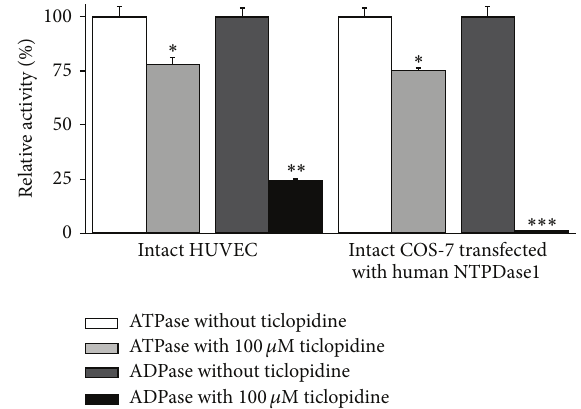
Figure 1: Influence of ticlopidine on intact HUVEC and COS-7 cells transfected with an expression vector encoding human NTPDase1. The substrate (ATP or ADP) was added together with ticlopidine, both at 100 𝜇 M. Relative activities are expressed as the mean ± SD of 3independentexperimentswithconfluentcells(HUVECfromthree different donors at passage 2), each performed in triplicate; mean cell number in one well was in the order of 250,000. The activity (without ticlopidine, which was set at 100%) with the substrate ATP corresponded to 2.5 ± 0.12 and 16.7 ± 0.8 nmol P i ⋅ min −1 ⋅ well −1 for to 3.5 ± 0.17 and 9.1 ± 0.45 nmol P i ⋅ min −1 ⋅ well −1 for HUVEC